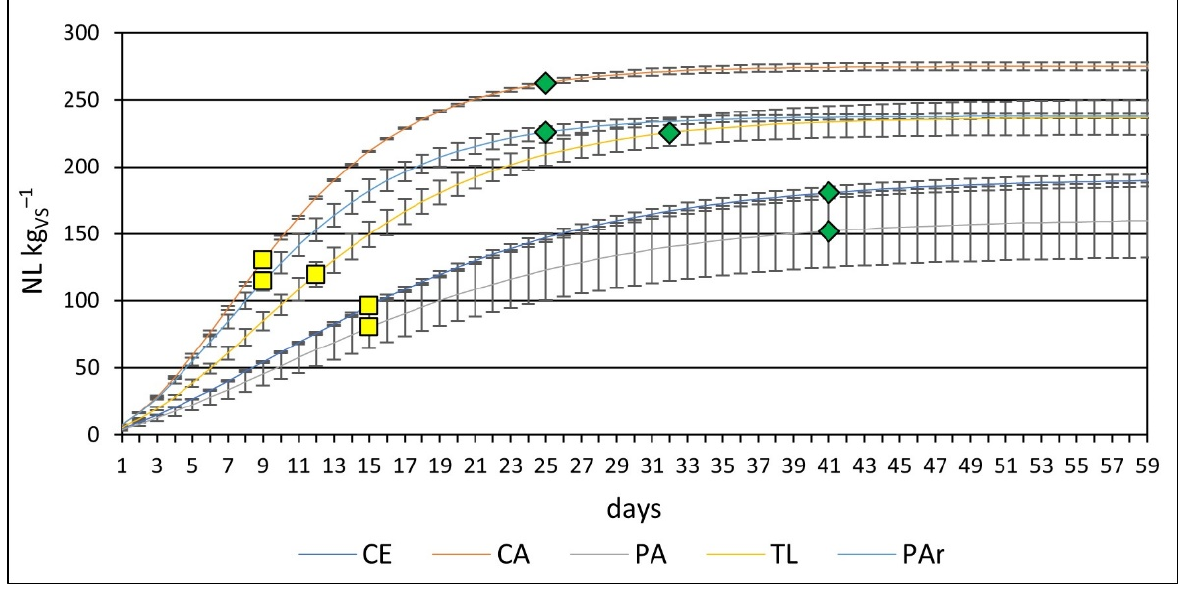
Figure 3. Daily methane production: ( a )—wet fermentation; ( b )—dry fermentation. CE— Carex elata ; CA— Carex acutiformis + Carex elata ; PA— Phragmites australis ; TL— Typha latifolia ; PAr— Phalaris arundinacea . Standard errors are shown as vertical bars.